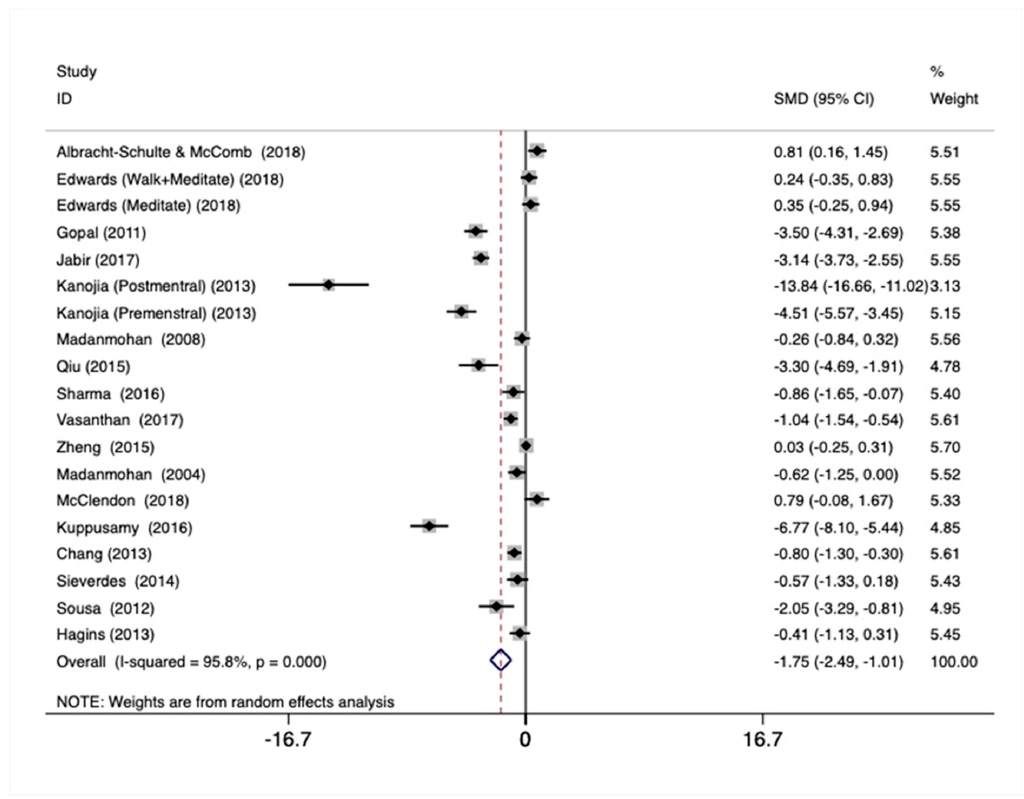
Figure 2. Forest plot showing the weighted pooled effect of Mind–Body physical activity interventions on heart rate.